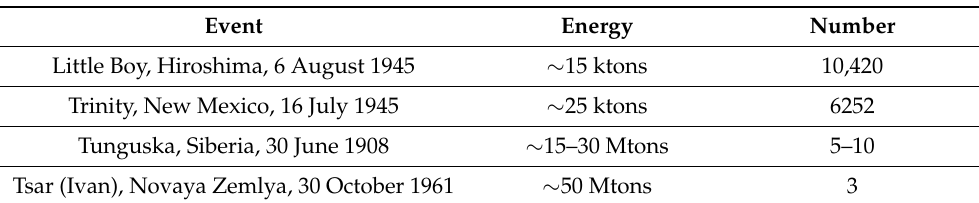
Table 7. Approximate Calculations for Kinetic Energy Equivalence (TNT) and Quantity for a Daedalus probe approaching Barnard’s Star.